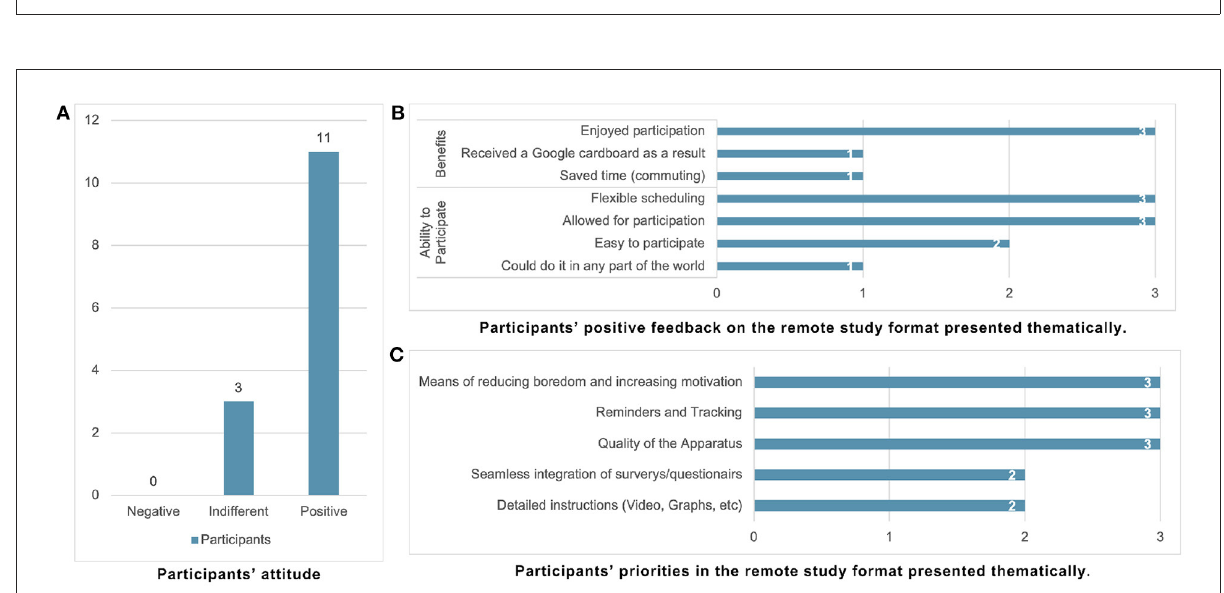
FIGURE8 Participants’ feedback and priorities in the remote study format, presented thematically. (A) Participant’s attitude. (B) Participant’s positive feedback the remote study format presented themat. (C) Participant’s priorities in the remote presented